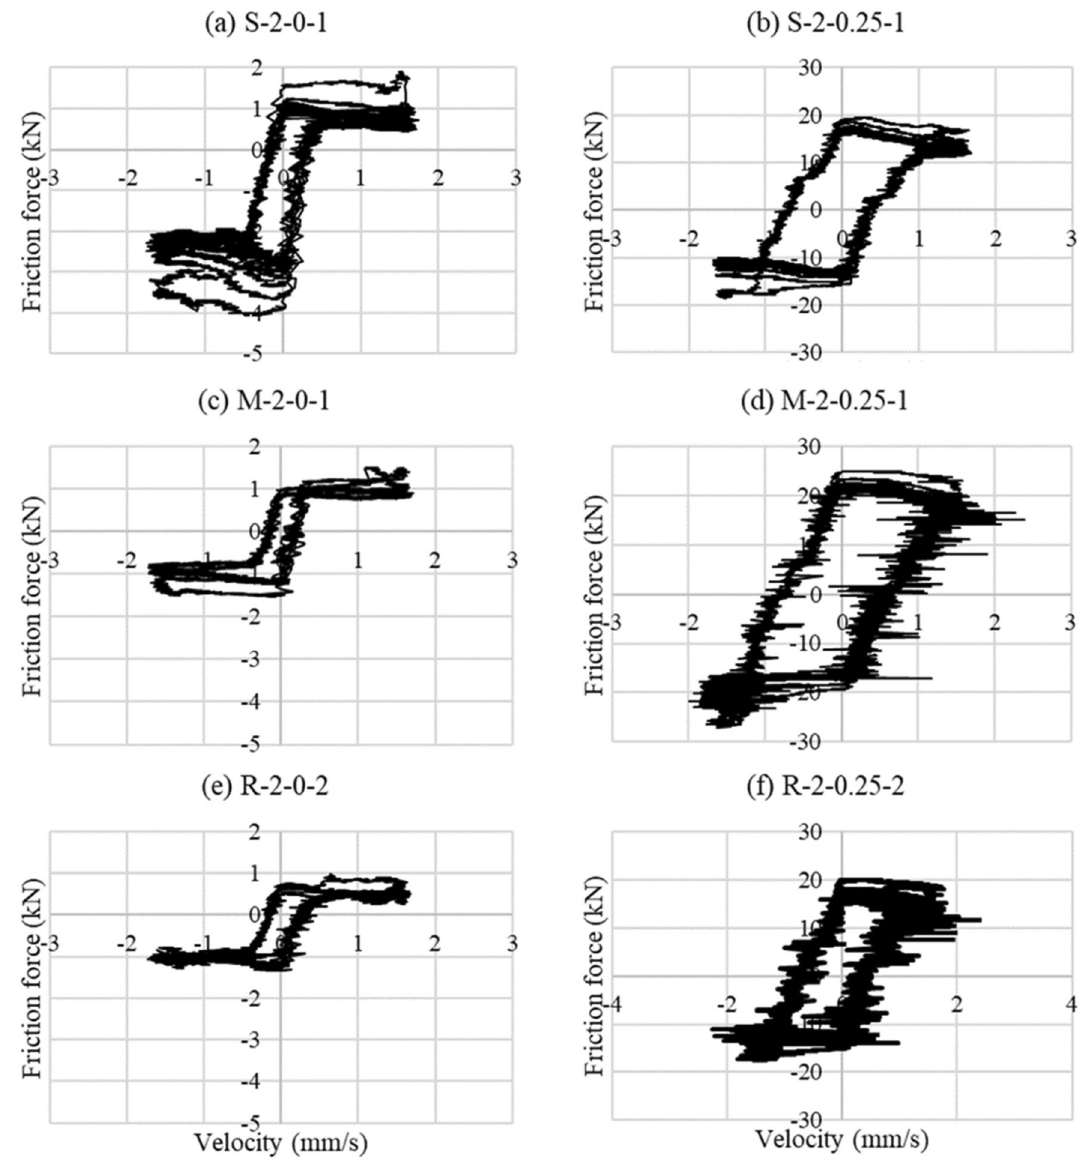
Figure 13. Friction force versus velocity